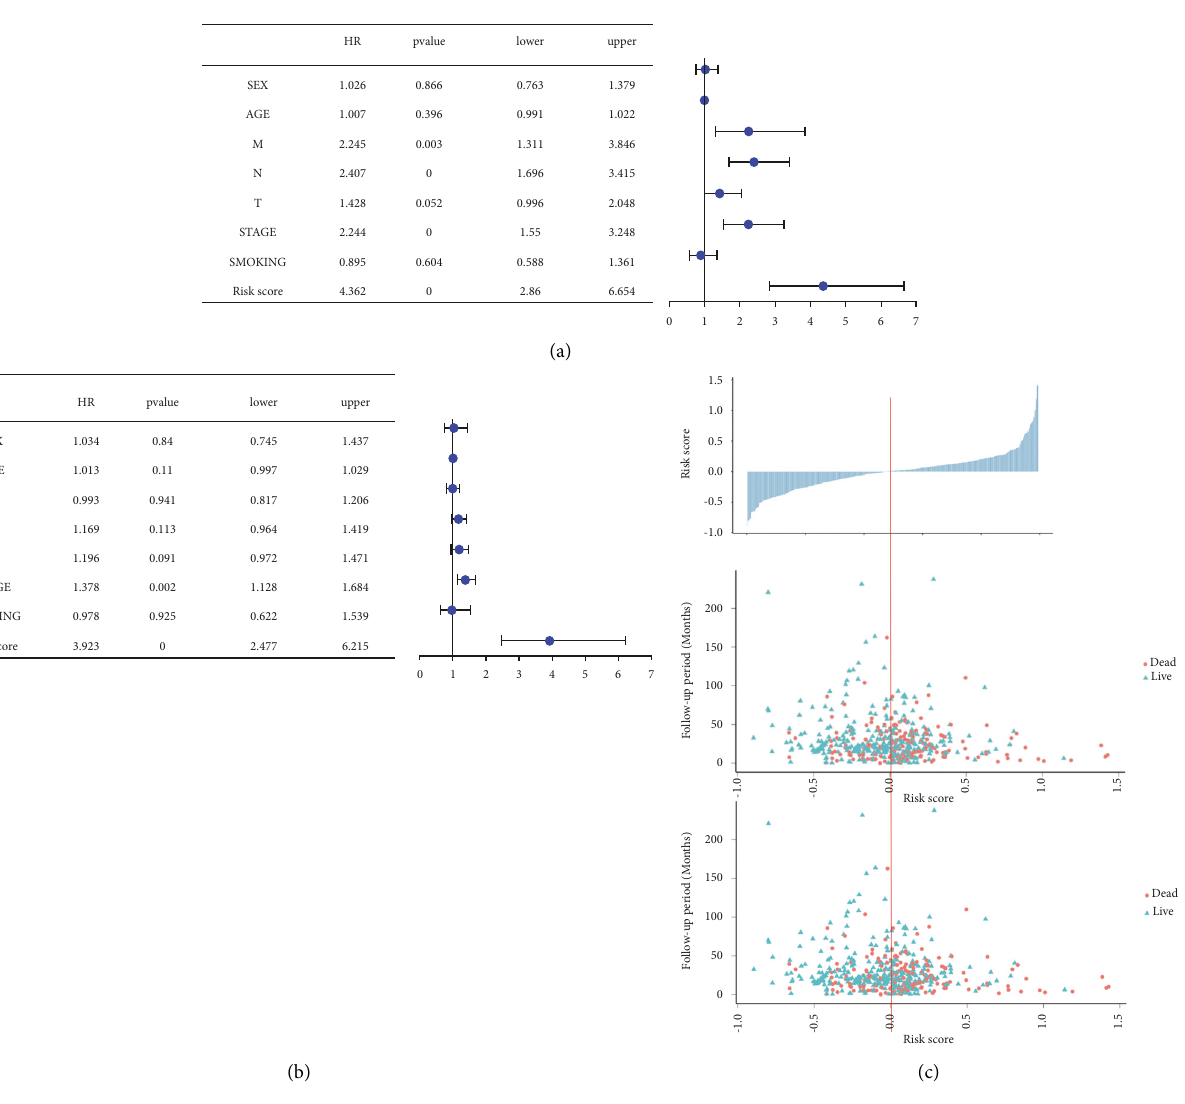
Figure 7: The training and validation sets’ univariate and multivariate COX analyses to identify risk variables and the patient’s risk survival status. (a) Univariate Cox analysis detected clinical factors related to OS; (b) multivariate Cox analysis identified clinical factors related to OS; (c) the survival time of OS (middle) and survival time of PFI (bottom) changed with the increase of the score after sorting the risk scores calculated by the prognostic model from low to